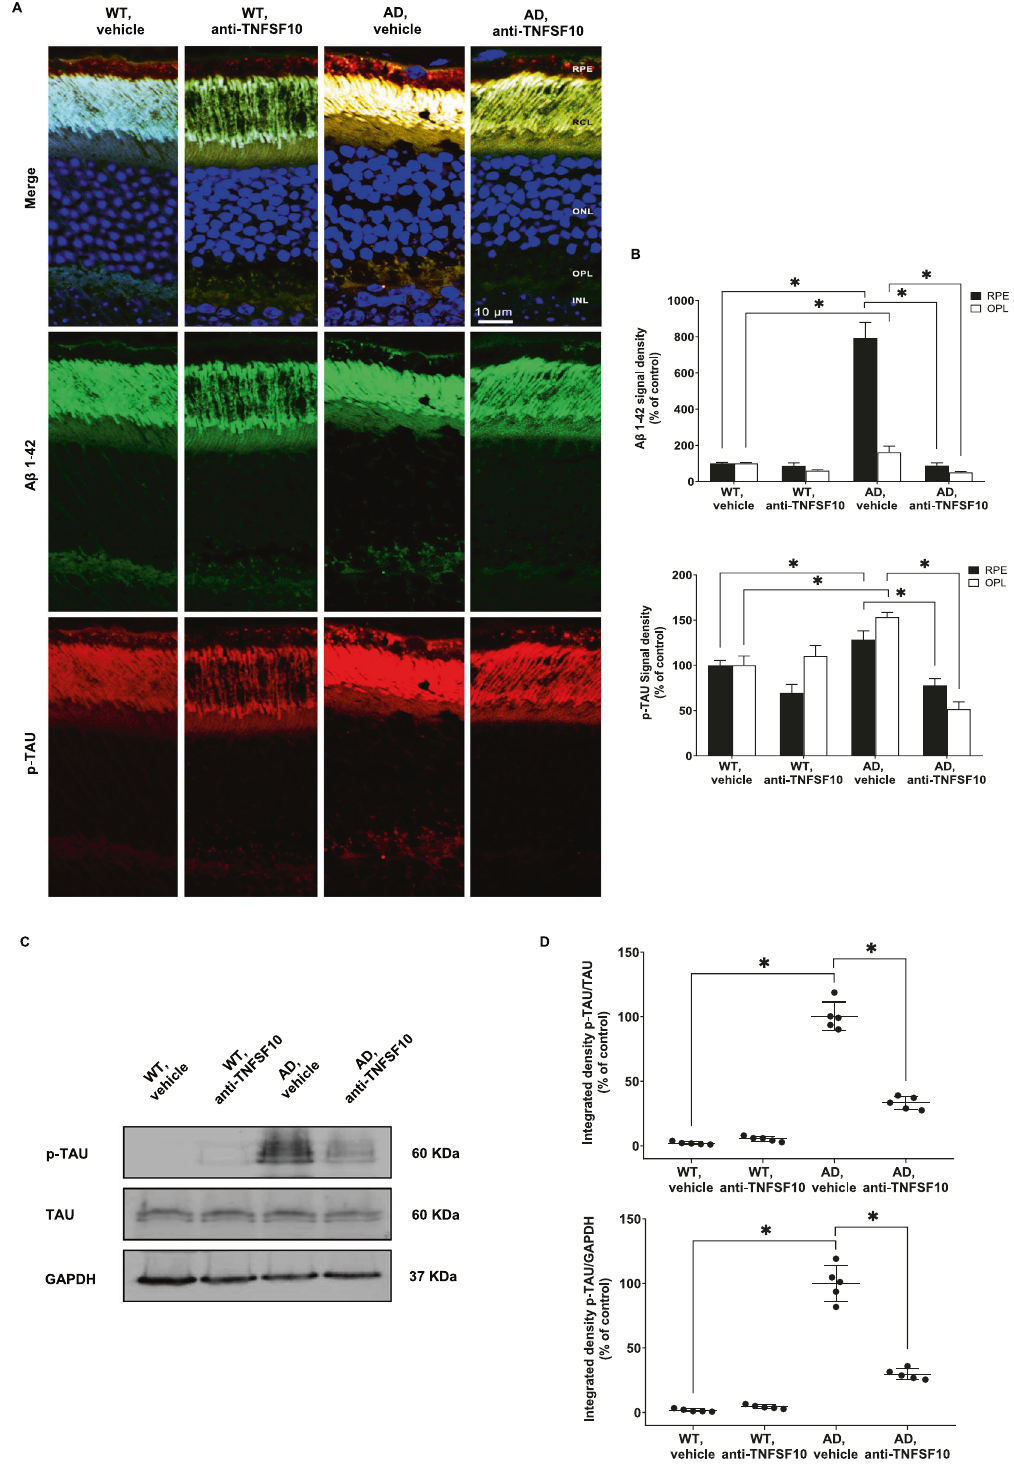
Fig. 8 Anti-TNFSF10 treatment inhibited A β and p-TAU deposition in the outer-plexiform and in the RPE layers of the 3xTg-AD mouse retina. A Immunohistochemical staining for p-TAU in the retina of WT and 3xTg-AD mice treated with anti-TNFSF10 or vehicle. Original magni fi cation, x63. Scale bar = 10 µm. B Densitometric analysis of the p-TAU immuno fl uorescence signal in the RPE and OPL retinal layers. One-way ANOVA and post-hoc Tukey ’ s multiple comparisons test were used for statistical analysis. * p < 0.05. N = 5 animals; 5 independent retinal samples. For each retinal section, 14 optical fi elds were analyzed. C Western blot representative images for p-TAU protein expression in the retina of mice following chronic treatment with an anti-TNFSF10 monoclonal antibody or vehicle. D Densitometric analysis of western blots. Data are expressed as mean ± standard deviation. One-way ANOVA and post-hoc Tukey ’ s multiple comparisons test were used for statistical analysis. * p < 0.05. N = 5 animals; 5 independent retinal samples, 2 pooled retinas per sample in each group.